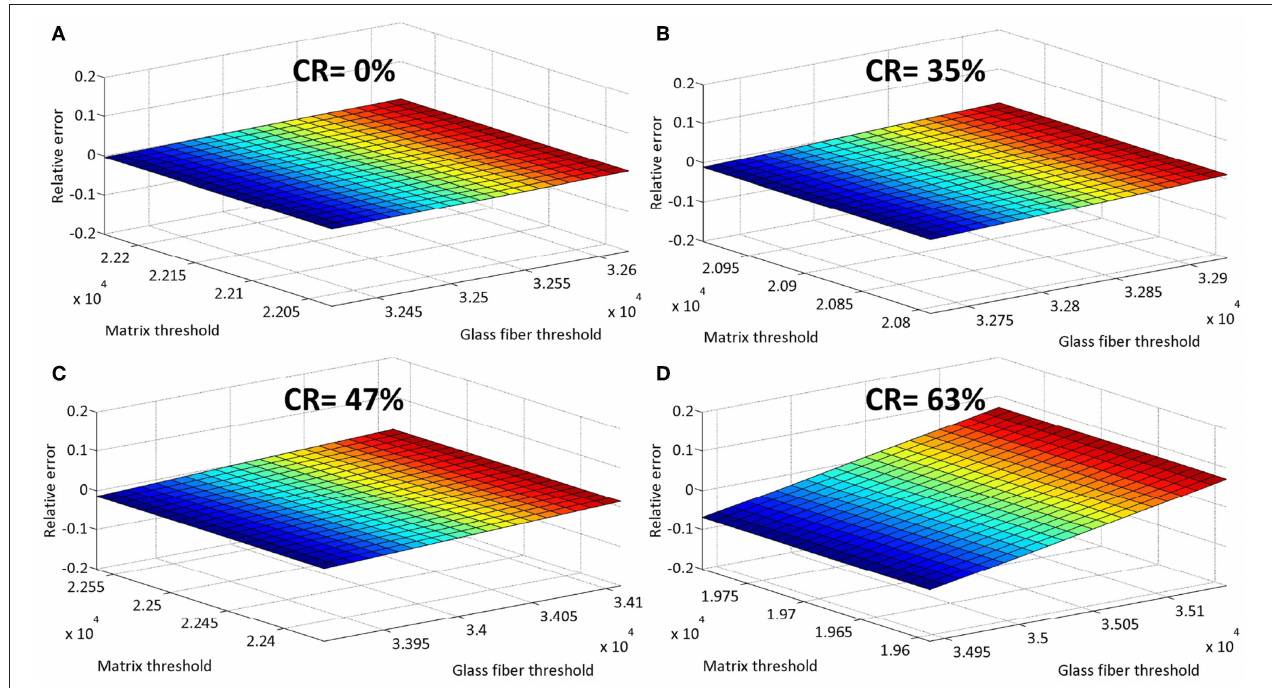
FIGURE 8 | Relative error distributions due to the imposed changes of gray level threshold for glass fibers and PP matrix. (A–D) Correspond respectively to the compaction ratios of 0; 35; 47 and